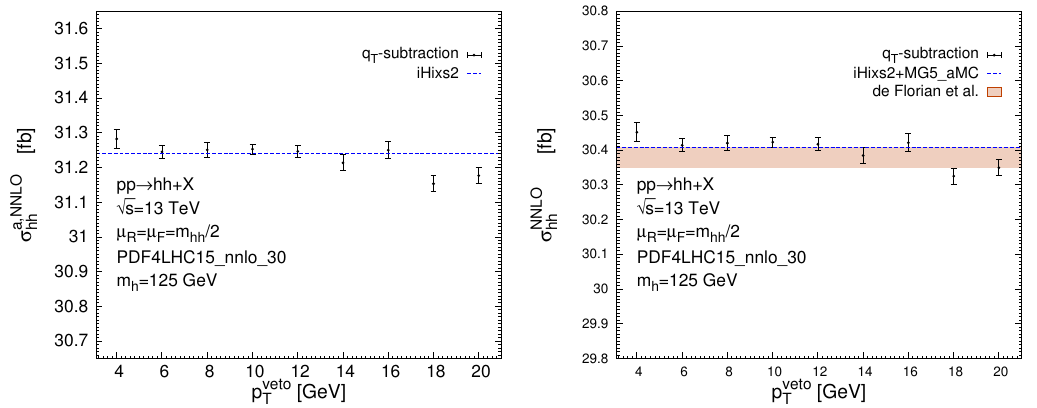
Figure 4 . The comparisons of the NNLO class- a cross sections from two di(cid:11)erent approaches (left panel) and of the NNLO hh cross sections from three di(cid:11)erent calculations (right panel) at p s = 13 TeV LHC. The error bars denote the Monte Carlo integration uncertainties. In the right panel, the band represents the Monte Carlo integration error quoted in ref.